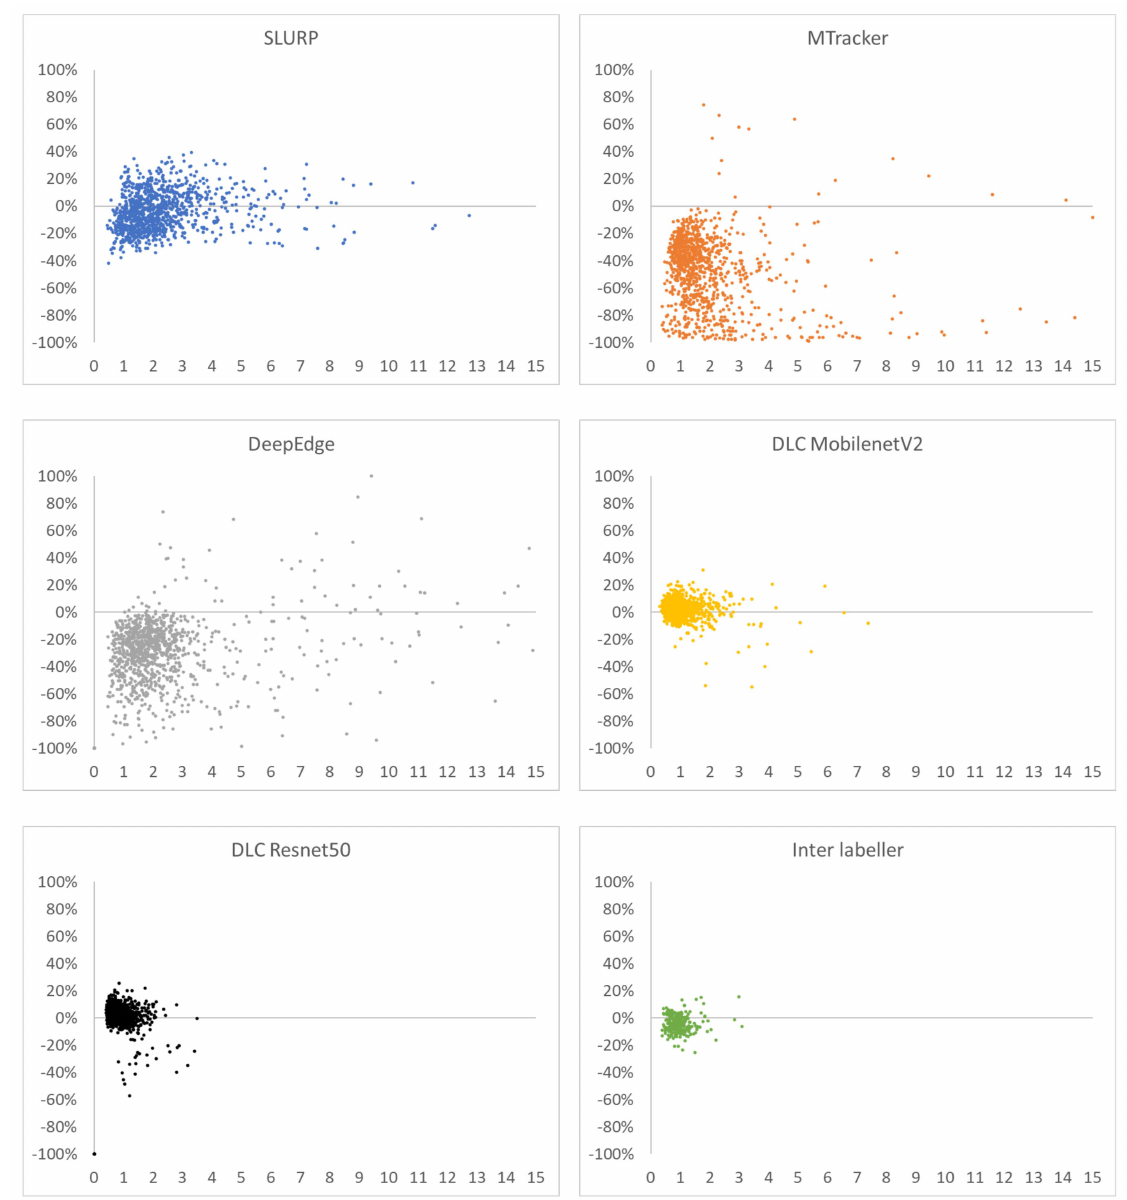
Figure 9. MSD vs. %length difference (hand-label estimator) for SLURP, MTracker, DeepEdge, DLC MobileNetV2, DLC ResNet50, and second